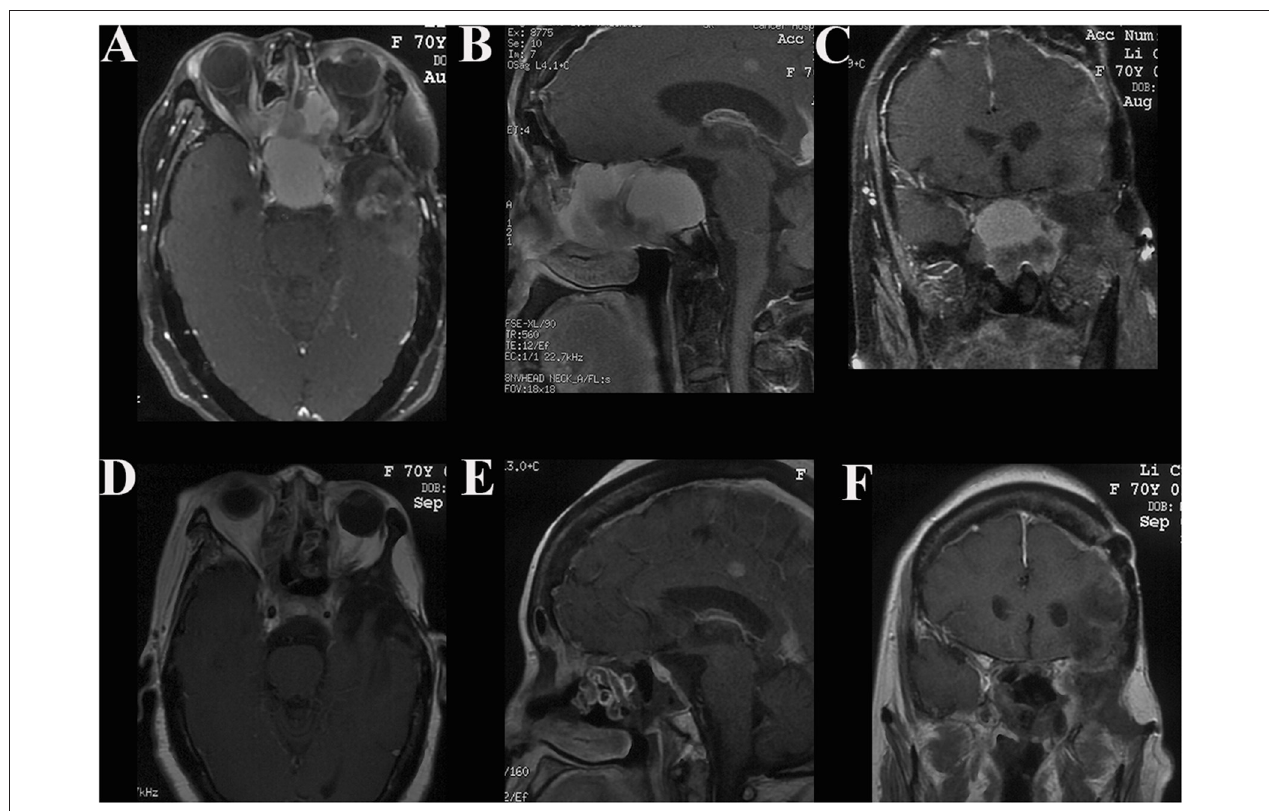
FIGURE 6 | Case illustrating the endoscopic endonasal approach. (A–C) T1-weighted axial, sagittal, and coronal contrast-enhanced MRIs demonstrate an anterior skull base tumor with extension to the sphenoid sinus, ethmoidal sinus, and nasal cavity with moderate enhancement. (D–F) Postoperative contrast-enhanced MRIs indicate satisfactory tumor